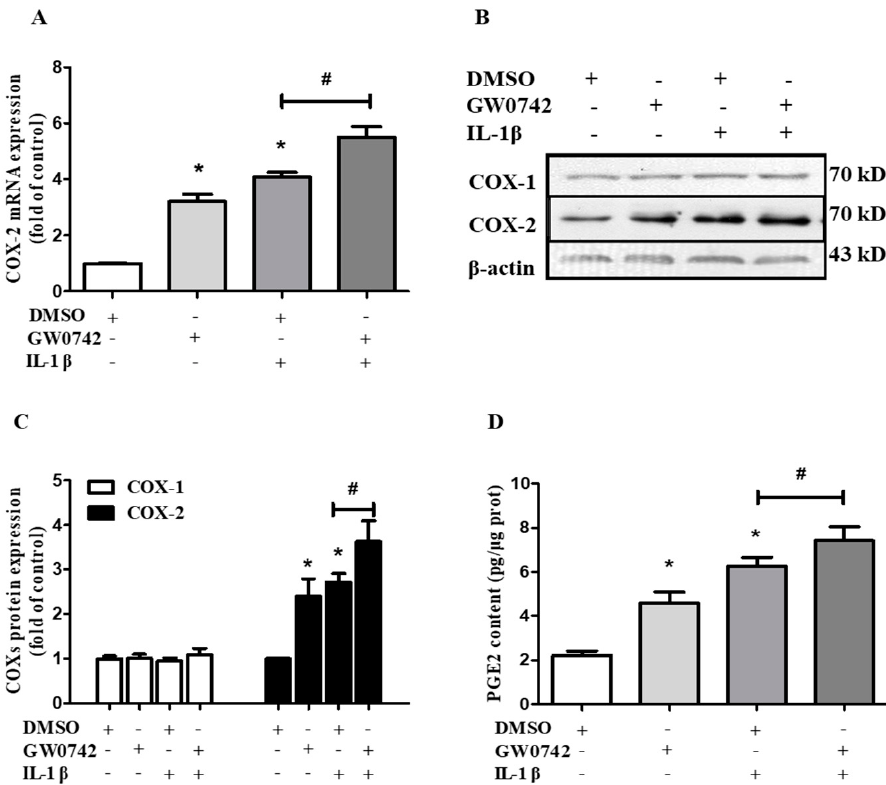
Figure 4. PPAR β / δ augments IL-1 β -induced COX-2 expression and PGE2 production. The cells were incubated with DMSO or GW0742 (1 µ M) for 6 h and then stimulated with or without IL-1 β (5 ng/mL) for 12 h. ( A ) A real-time PCR analysis showed the induction of COX-2 mRNA expression by the PPAR β / δ agonist GW0742. ( B , C ) A Western blot assay demonstrated that GW0742 induced COX-2 protein expression with little effect on the COX-1 levels. ( D ) GW0742 treatment significantly augmented IL-1 β -induced PGE2 production. * p < 0.05 vs. DMSO; # p < 0.05 vs. IL-1 β ; n = 4.